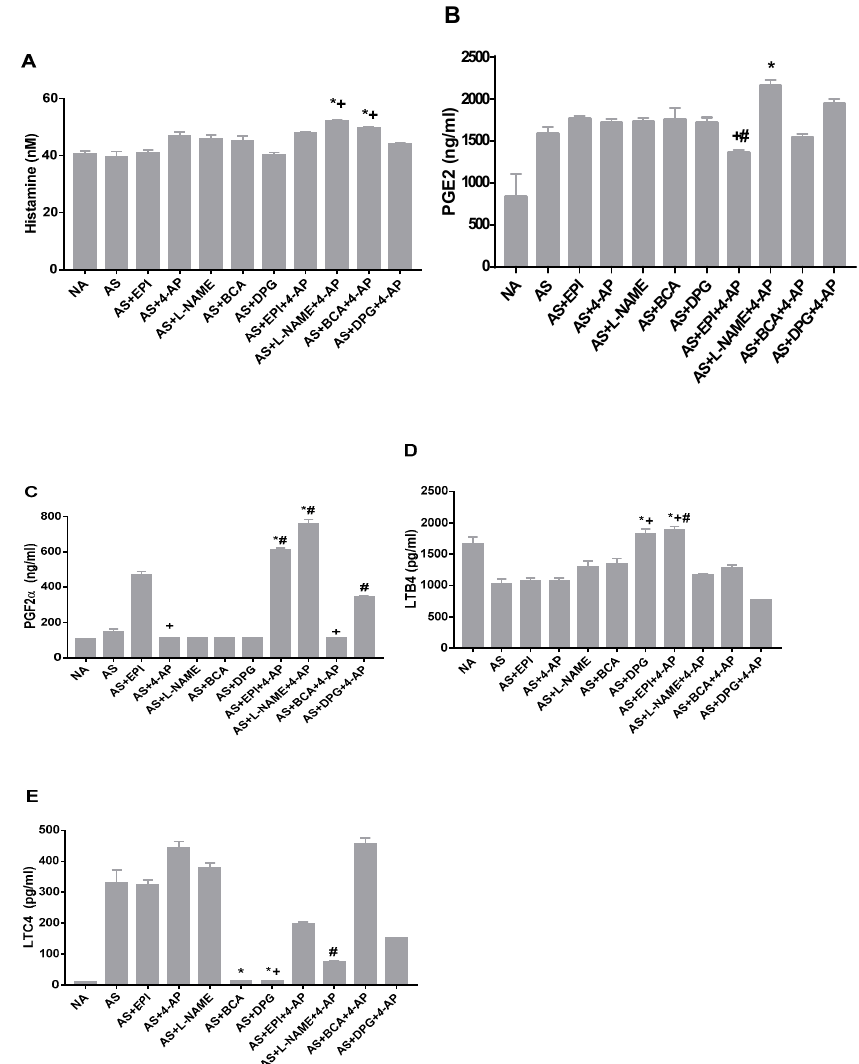
Figure 5. AS arterial plasma concentrations of the allergic and inflammatory mediators histamine ( A ), prostaglandin E2 (PGE2) ( B ), prostaglandin F2 α (PGF2 α ) ( C ), leukotriene B4 (LTB4) ( D ), and leukotriene C4 (LTC4) ( E ) after OVA injection in untreated AS rats, rats treated with EPI, L-NAME, DPG, BCA,4-AP or EPI, and rats treated with the 4-AP drug combinations with L-NAME+4-AP, BCA+4-AP, DPG+4-AP or EPI+4-AP. Values are Mean ± S.E.M; * p < 0.05 vs. AS group; + p < 0.05 vs. EPI group; # p < 0.05 vs. 4-AP group. NA, non-allergic rats; AS, allergic rats; BCA, β -cyanoalanine; DPG, dl-propargylglycine; L-NAME, L-NG-Nitroarginine methyl ester; 4-AP, 4-aminopyridine; EPI, epinephrine. BCA+4-AP, β -cyanoalanine+4-aminopyridine; DPG+4-AP, dl-propargylglycine+4-aminopyridine; L-NAME+4-AP, L-NG-Nitroarginine methyl ester+4-aminopyridine; EPI+4-AP, epinephrine+4-aminopyridine.